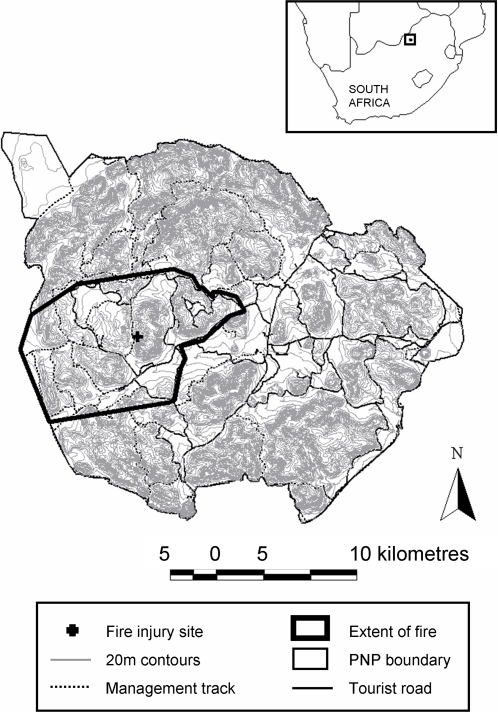
Map of Pilanesberg National Park incorporating 20 m contours, tourist roads, management tracks, the site where elephants were injured in a fire on 21 September 2005 and the approximate extent of the fire.